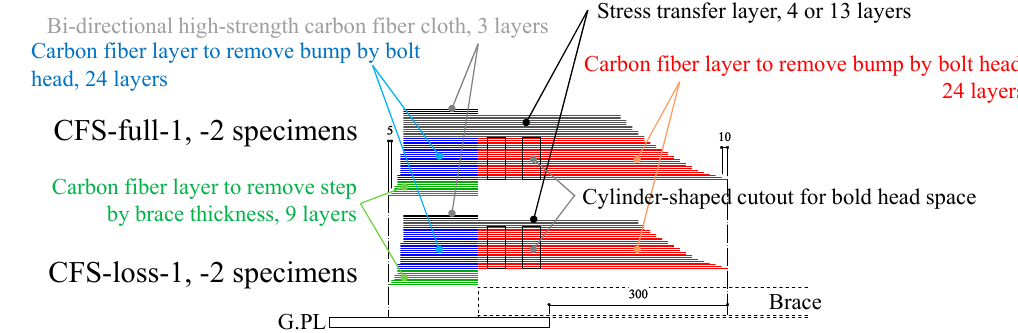
Figure 8. Lamination condition of CFRP strengthening.